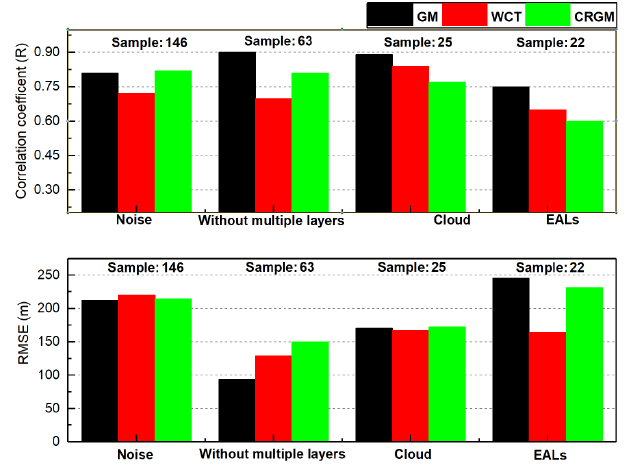
Figure 5. Correlation coefficient and RMSE results compared with the CA-GM method under all conditions (see text for details) using the gradient method (GM), wavelet covariance transform transition method (WCT), and cubic root gradient method (CRGM). The sam- ple number is shown at the top of the column, and the condition is represented by the x